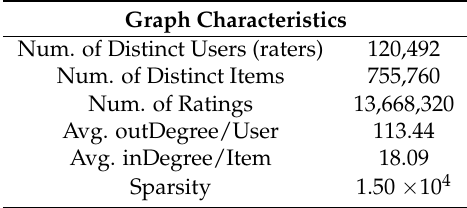
Table 1. Characteristics of the Epinions dataset bipartite